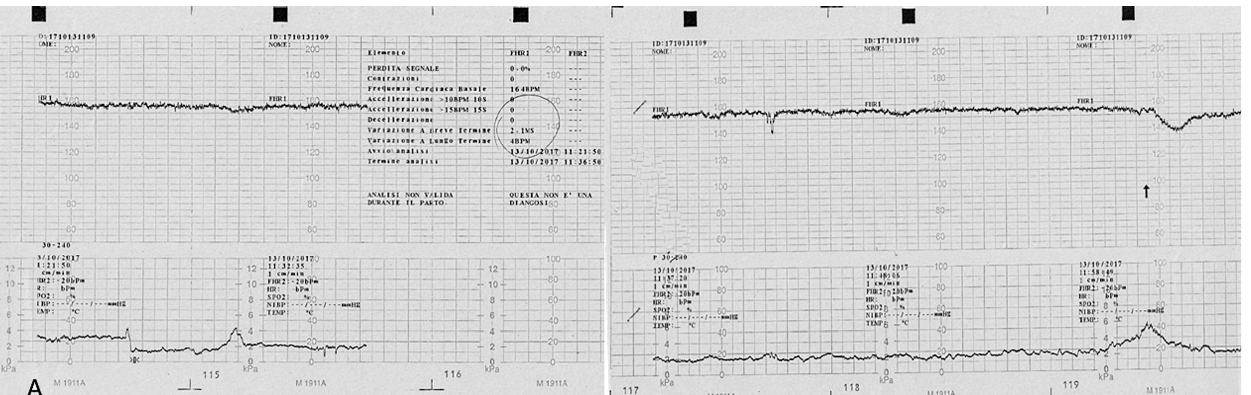
Figure 3. Computerized electronic fetal monitoring (EFM) during antepartum: a baseline fetal heart rate of 164 bpm is visible associated to an absent long-term variability (<5 bpm) and with shallow late deceleration (Class III American College of Obstetricians and Gynecologists classification).